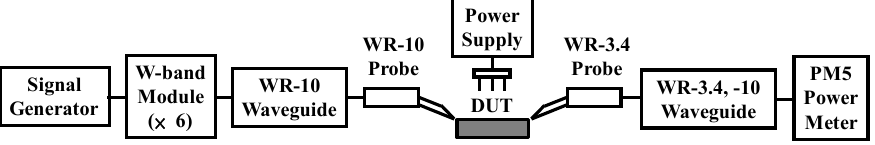
Figure 5. Photograph of the fabricated H -band frequency tripler IC.